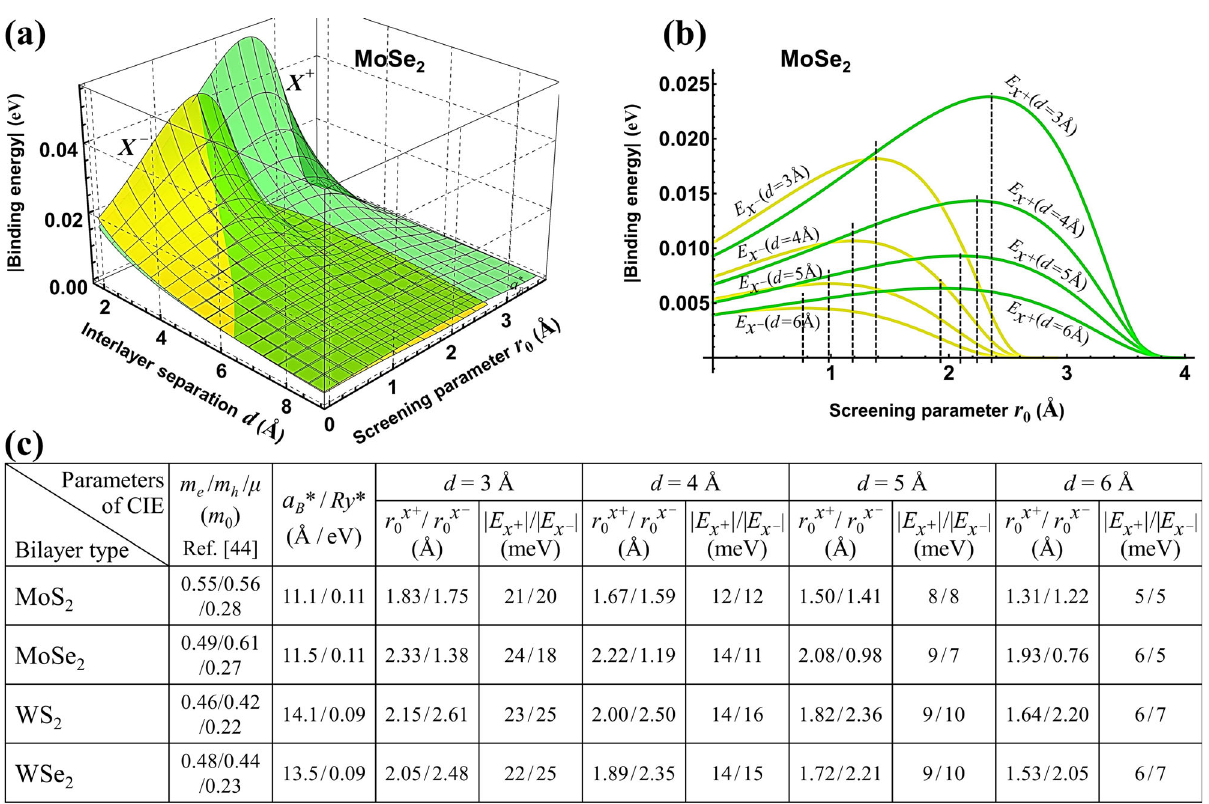
Fig. 4 Major characteristics of charged interlayer excitons in homobilayers. a An example of the MoSe 2 homobilayer embedded in bulk hBN (hexagonal boron nitride) material to present the positive ( X + ) and negative ( X − ) charged interlayer exciton (CIE) binding energy surfaces j E X ± j as functions of the interlayer separation d and the screening length parameter r 0 in physical units (eV for energy and Å for distance, respectively). b The fi xed- d crosscuts of ( a ) as functions of r 0 with the vertical dashed lines indicating the points of maxima to give the actual X + and X − binding energy absolute values for the interlayer separations d fi xed. c The data table to summarize the charged interlayer exciton (CIE) characteristics obtained for the four types of the hBN- encapsulated homobilayers. The homobilayers analyzed are collected in the left column. The next two columns present their respective electron m e , hole m μ ¼ ð m (cid:2) 1 þ m (cid:2) 1 Þ (cid:2) 1 effective masses in units of the free electron mass m 47 ), h and reduced e h 0 (reported previously from the density functional calculations and the effective exciton Bohr radia a (cid:3) B along with the effective exciton Rydberg energies Ry * we obtain and use in our analysis. The other columns (left to right) are divided in three groups to show the screening length parameters r X ± and the absolute values of the binding energies j E X ± j of the positive and 0 negative charged interlayer excitons (CIEs) for the three values of the interlayer separations d in the four bilayers